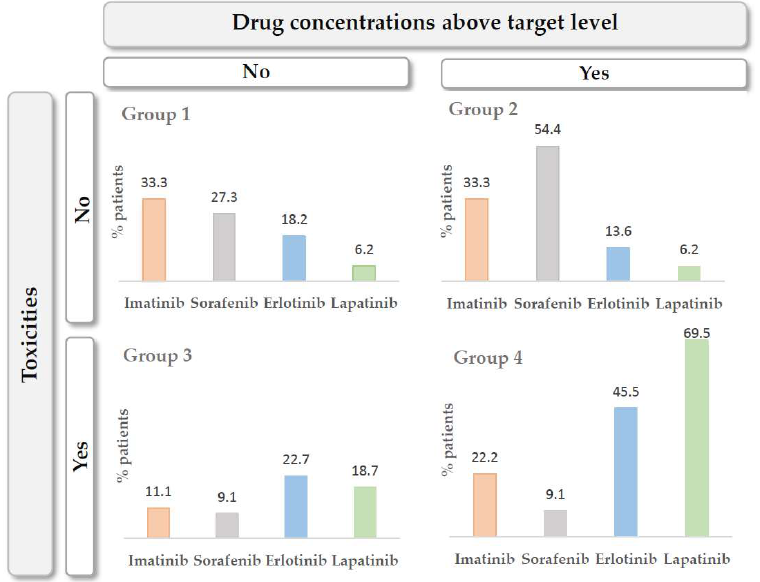
Figure 2. Groups of patients according to exposure to the drugs under